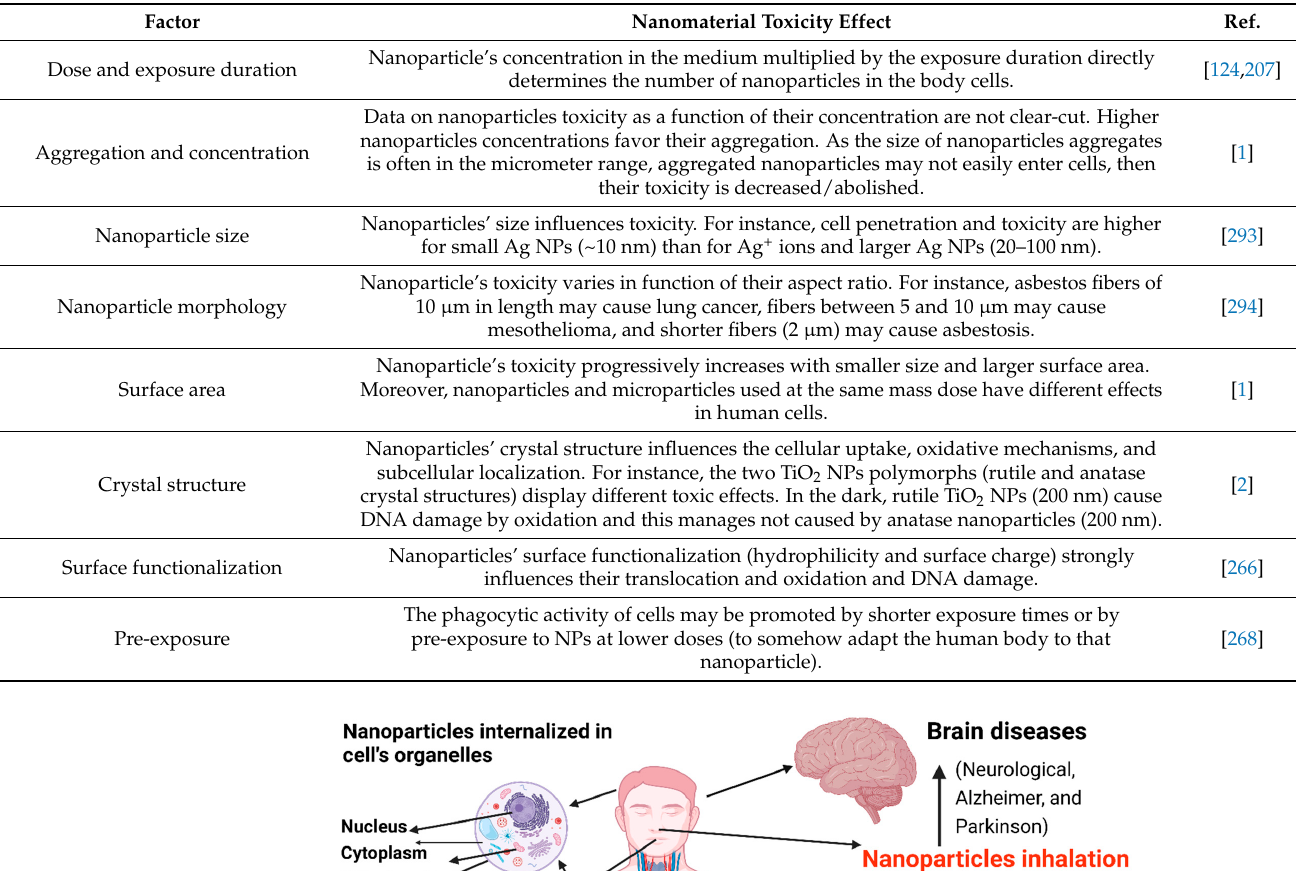
Table 6. Factors implicated in nanomaterial toxicity.